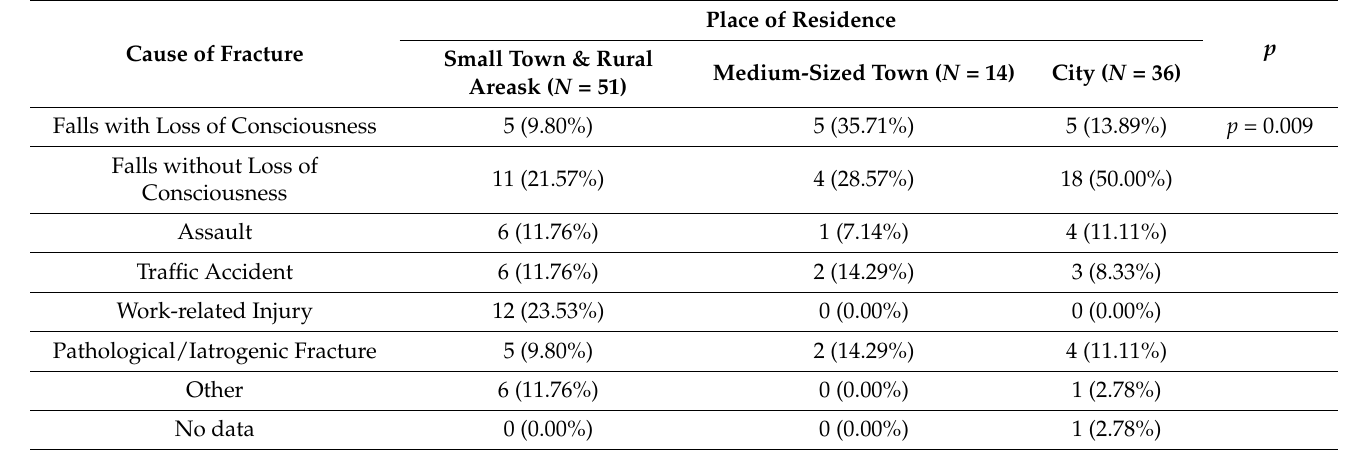
Table 11. Place of residence and cause of